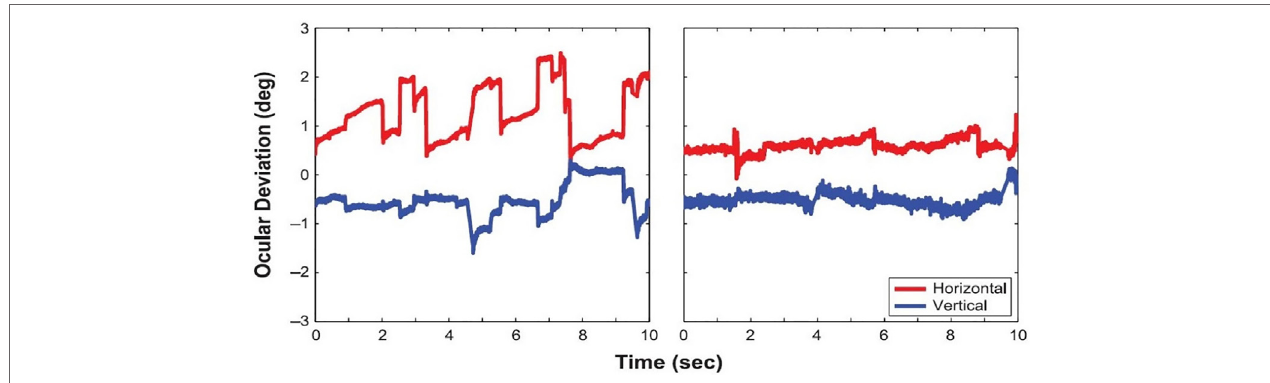
FigURe 5 | Eye positions during fixation in a patient with macular disease (left) and a healthy control subject (right). From Kumar and Chung (57).